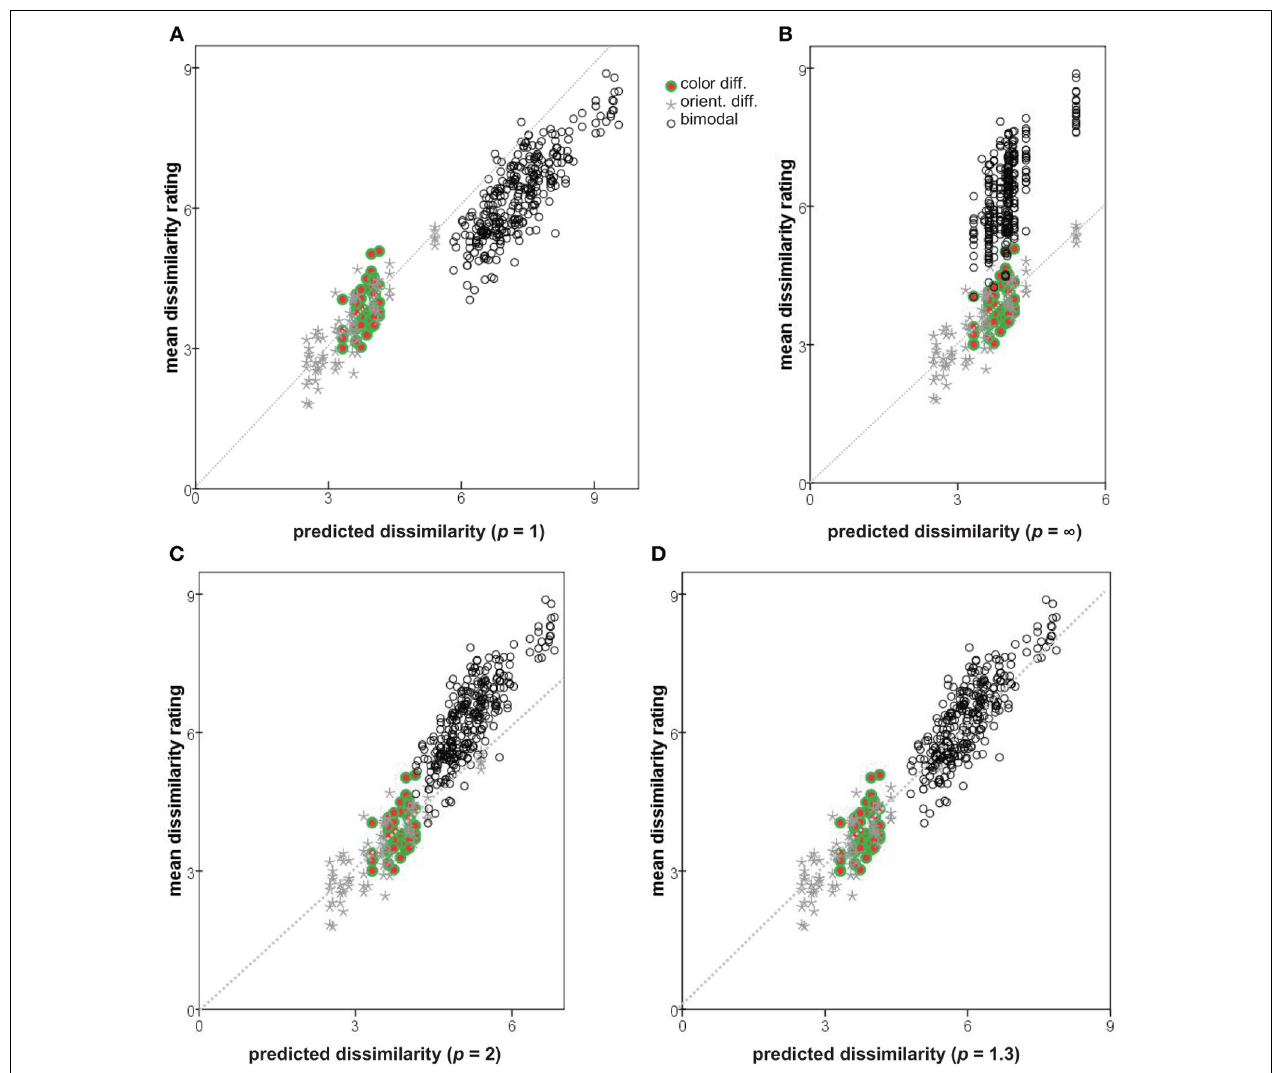
FIGURE 8 | Observed dissimilarity ratings plotted against values predicted by combining (cid:2) mn and (cid:2) ab with different Minkowski exponents. (A) p = 1; (B) p → ∞ ; (C) p = 2; (D) p = 1 . 3. Diagonals shown as dotted